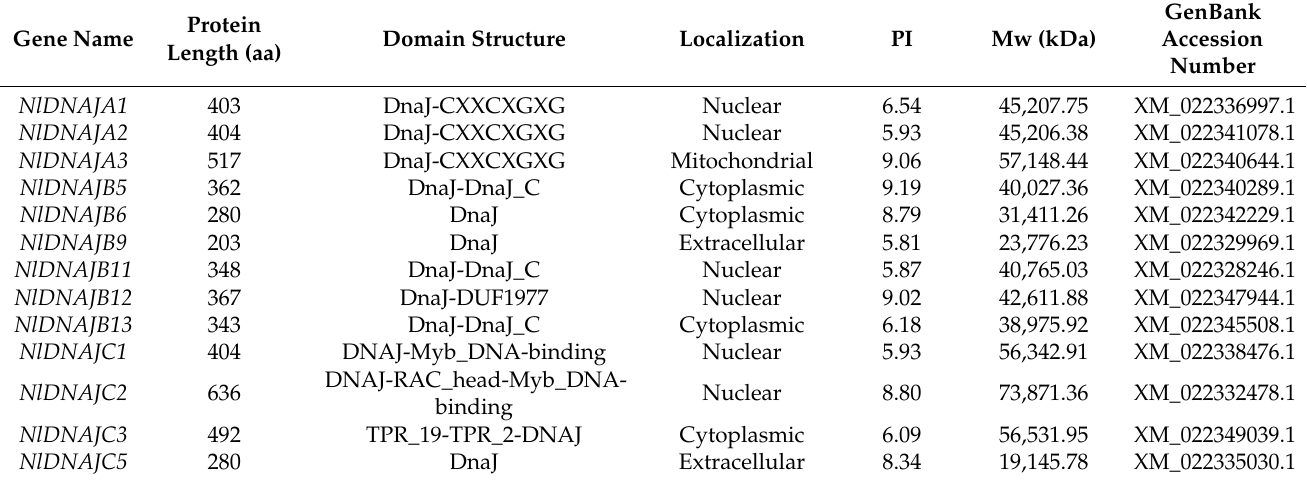
Table 1. Summary of DNAJ and HSP70 genes in brown planthopper